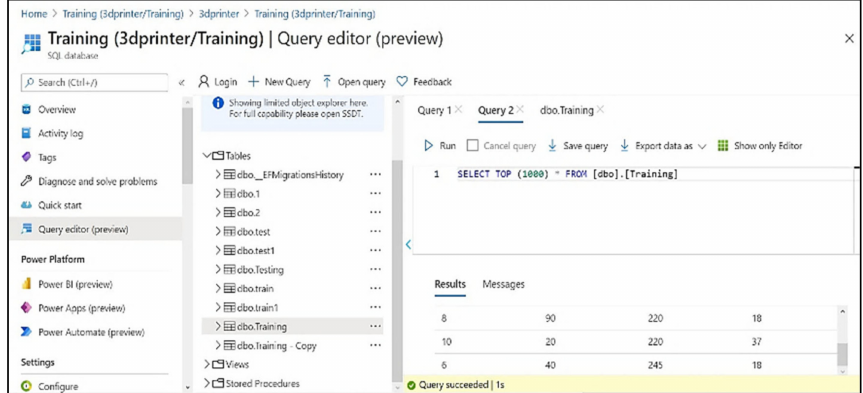
Figure 14. SQL database query.